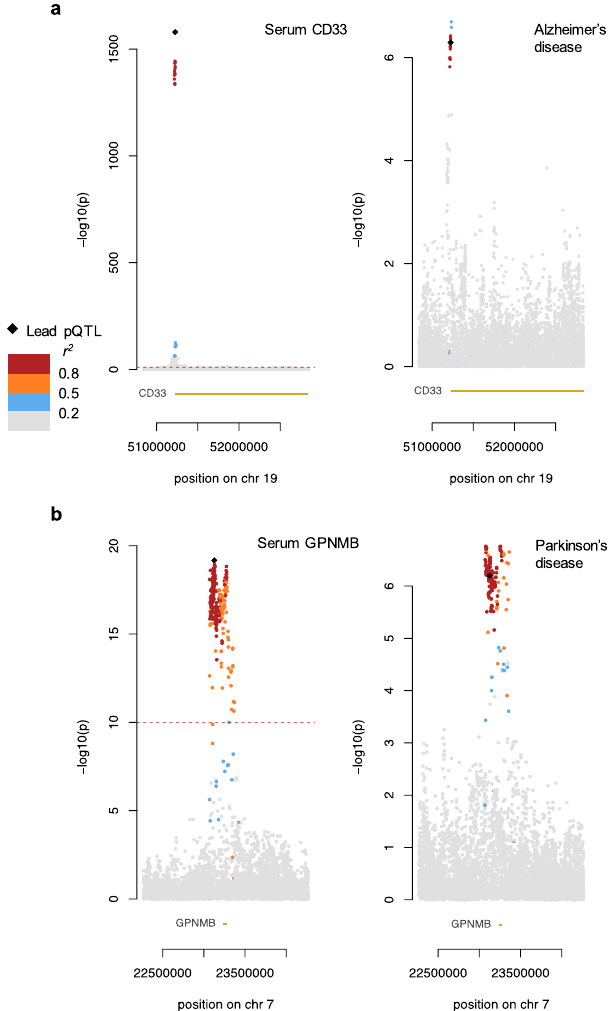
Fig. 4 Colocalisation plots. Each plot shows the association signal and the − log10 P -values. The lead pQTL variant is represented by a black diamond, while other points are variants that are coloured according to the extent of linkage disequilibrium with the lead variant. The location of the genes of interest are also shown in yellow at the bottom of each plot. Signi fi cance thresholds used for each respective study are shown using a dotted red line. a Left: Protein QTL signal for serum CD33; right: GWAS signal for Alzheimer ’ s disease. b Left: Protein QTL signal for serum GPNMB; right: GWAS signal for Parkinson ’ s